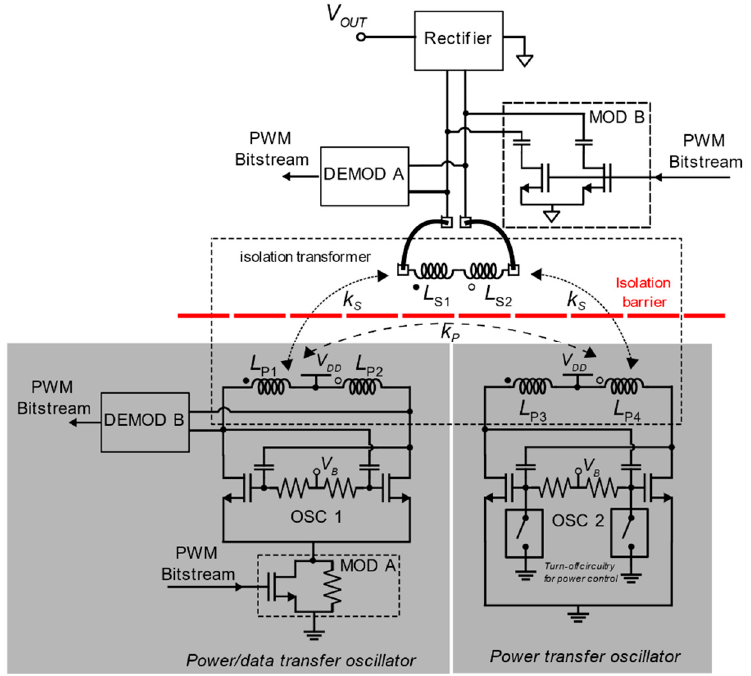
Figure 13. Simplified schematic of compact architecture for isolated GDs based on synchronized coupled oscillators.